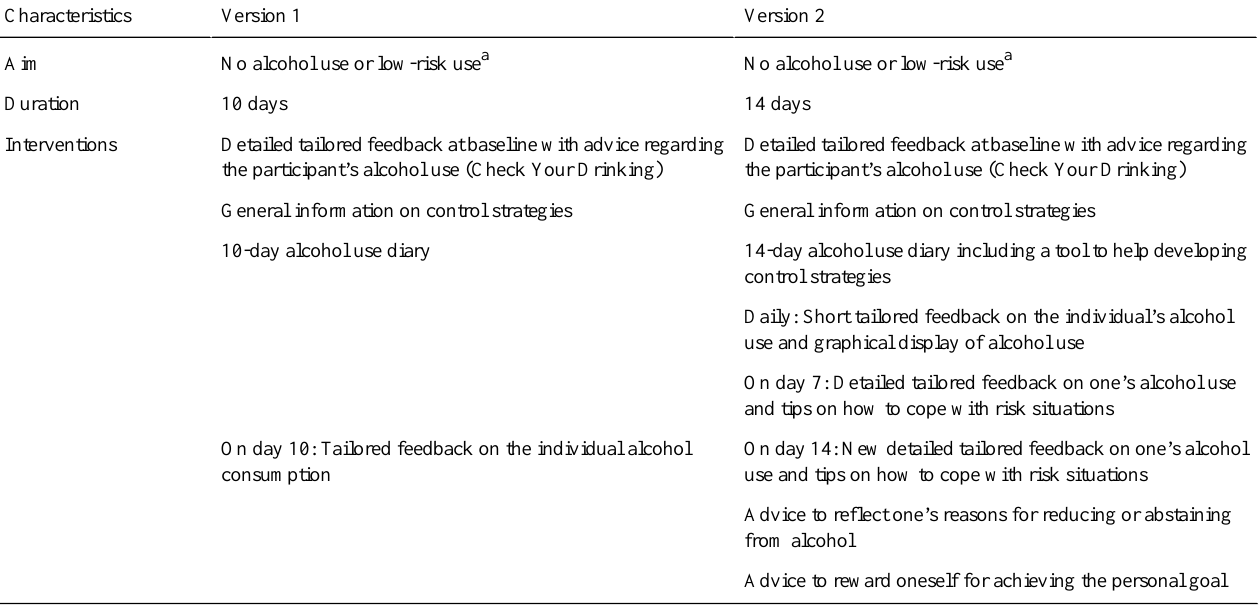
Table 1. Comparison of both Change Your Drinking